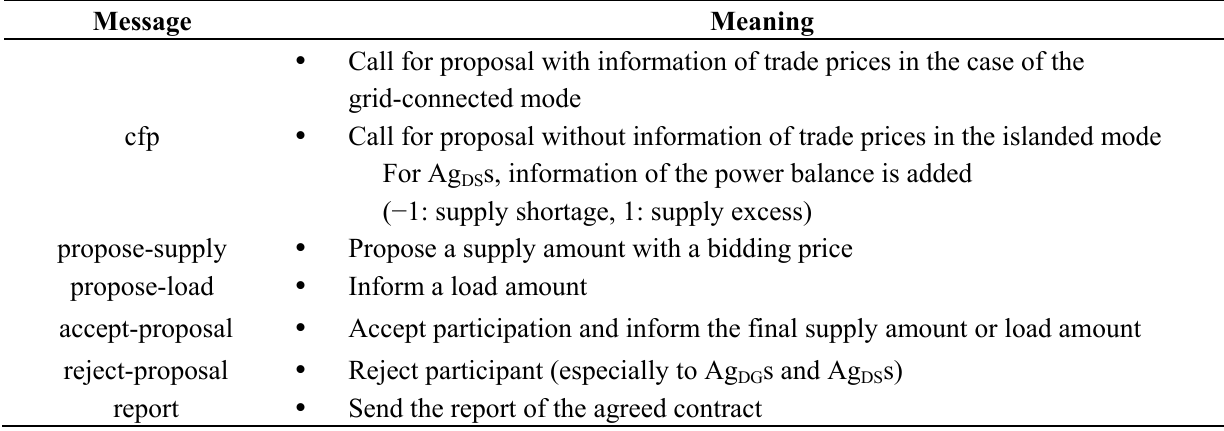
Table 1. Details of the defined